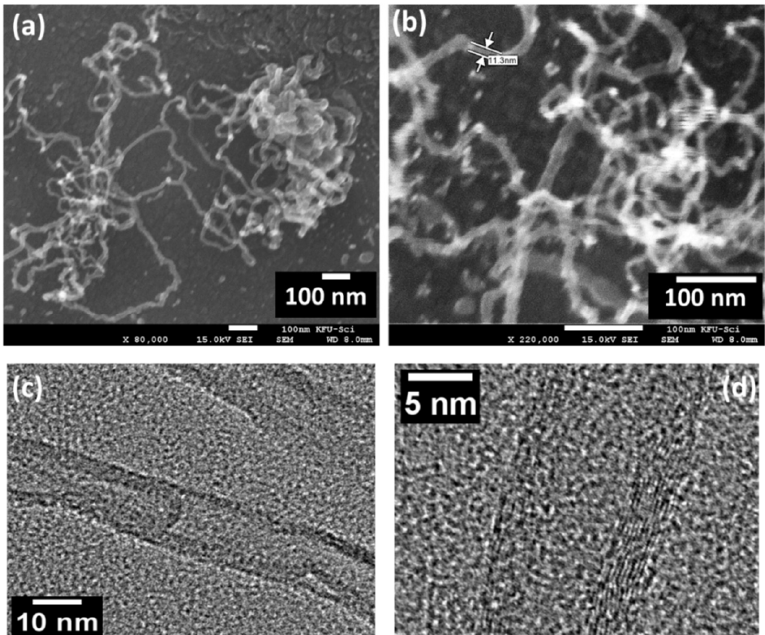
Figure 3. ( a , b ) Field emission scanning electron microscope images, ( c , d ) TEM and HRTEM images of the prepared CNTs.